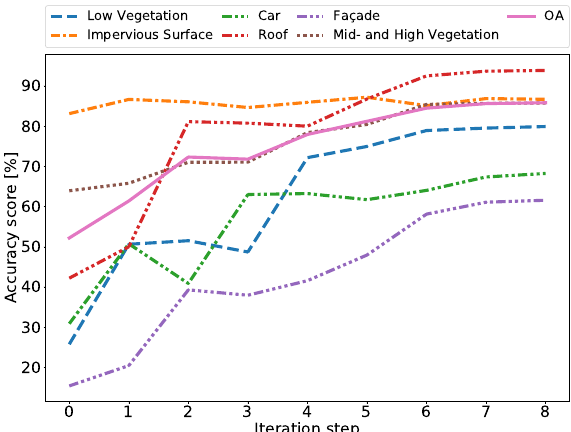
Figure 6. Achieved F1-scores per class ( dotted) and OA ( solid ) of the RF for the test set of V3D in the process of 8 iteration steps.